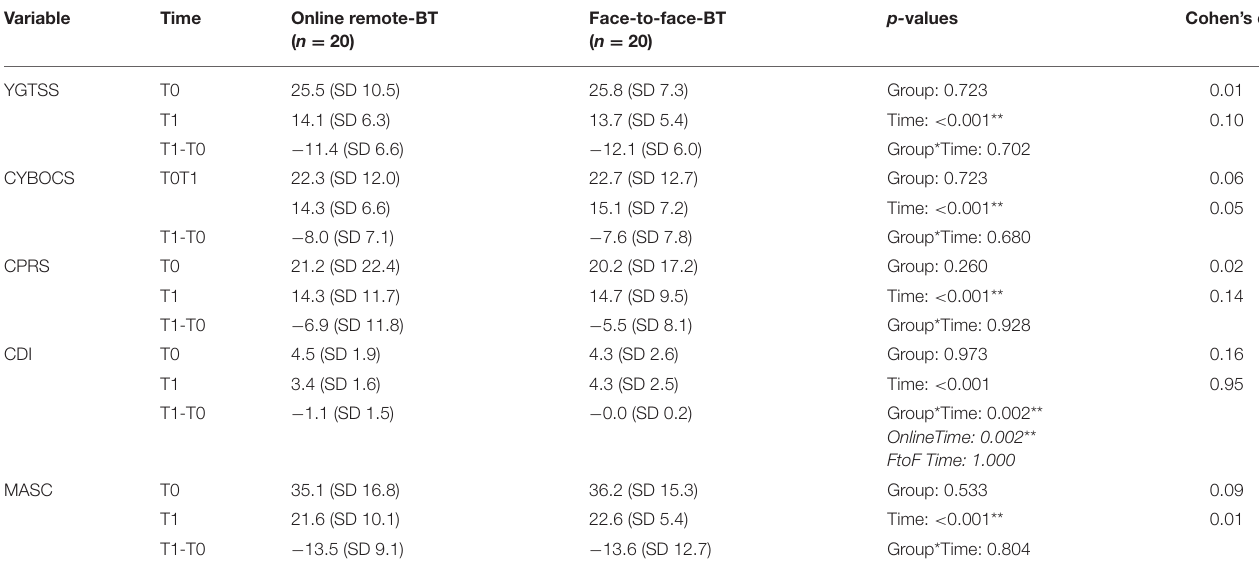
TABLE 2 | Outcome of neuropsychological findings. Variable